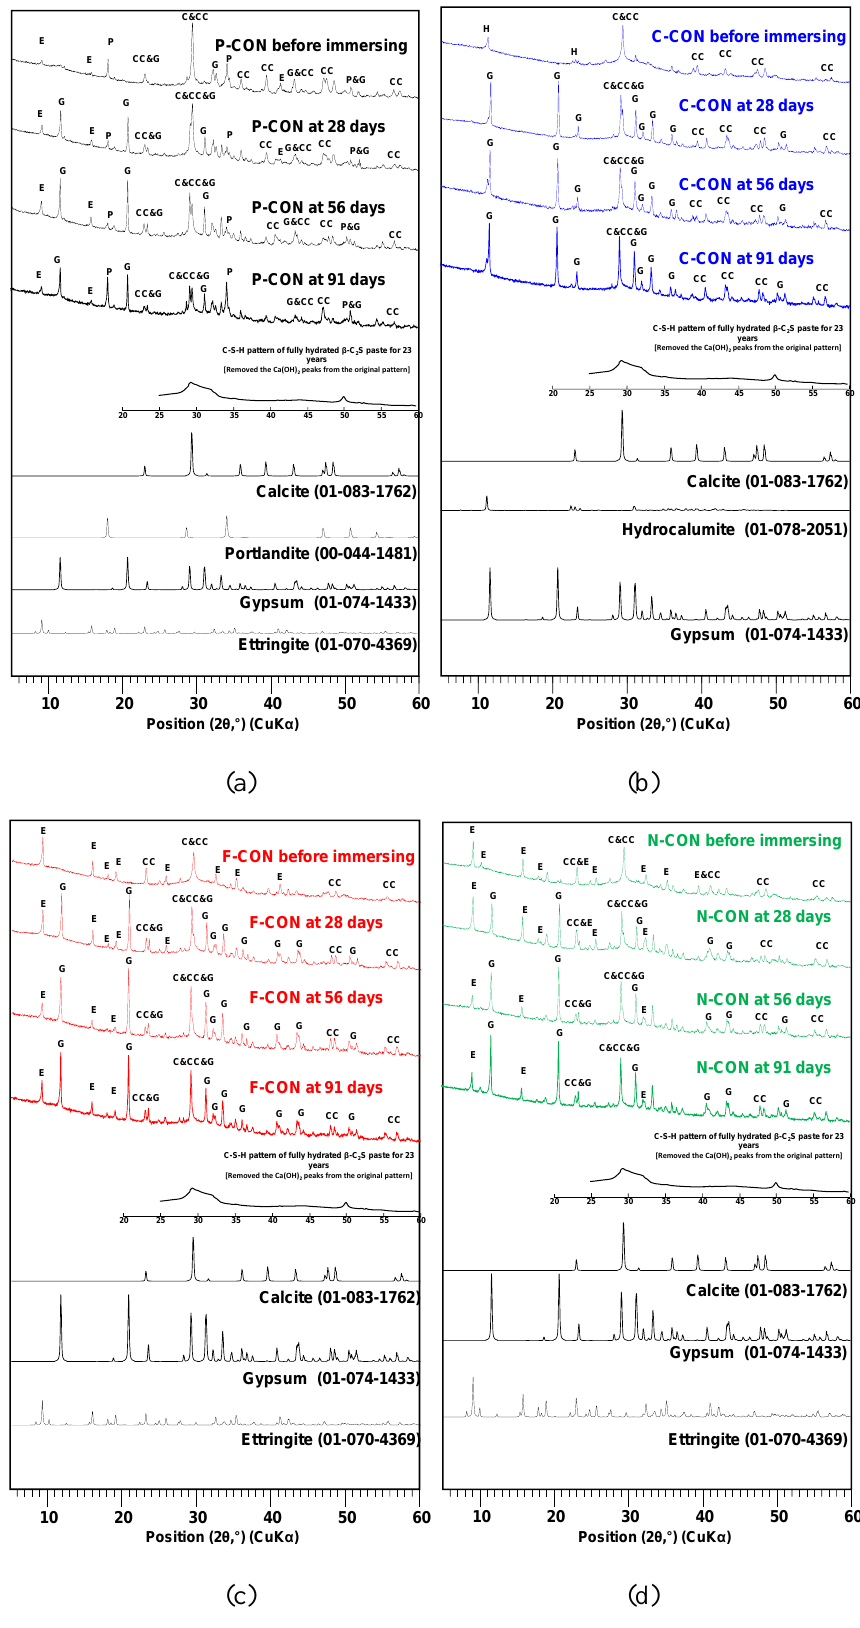
Figure 10. XRD patterns of hardened samples immersed in 5% H 2 SO 4 solution: ( a ) P-CON, ( b ) C- CON, ( c ) F-CON, and ( d ) N-CON. (Note. E: ettringite, C: C-S-H, CC: calcite, G: gypsum, H: hydroca- lumite, and P: portlandite,